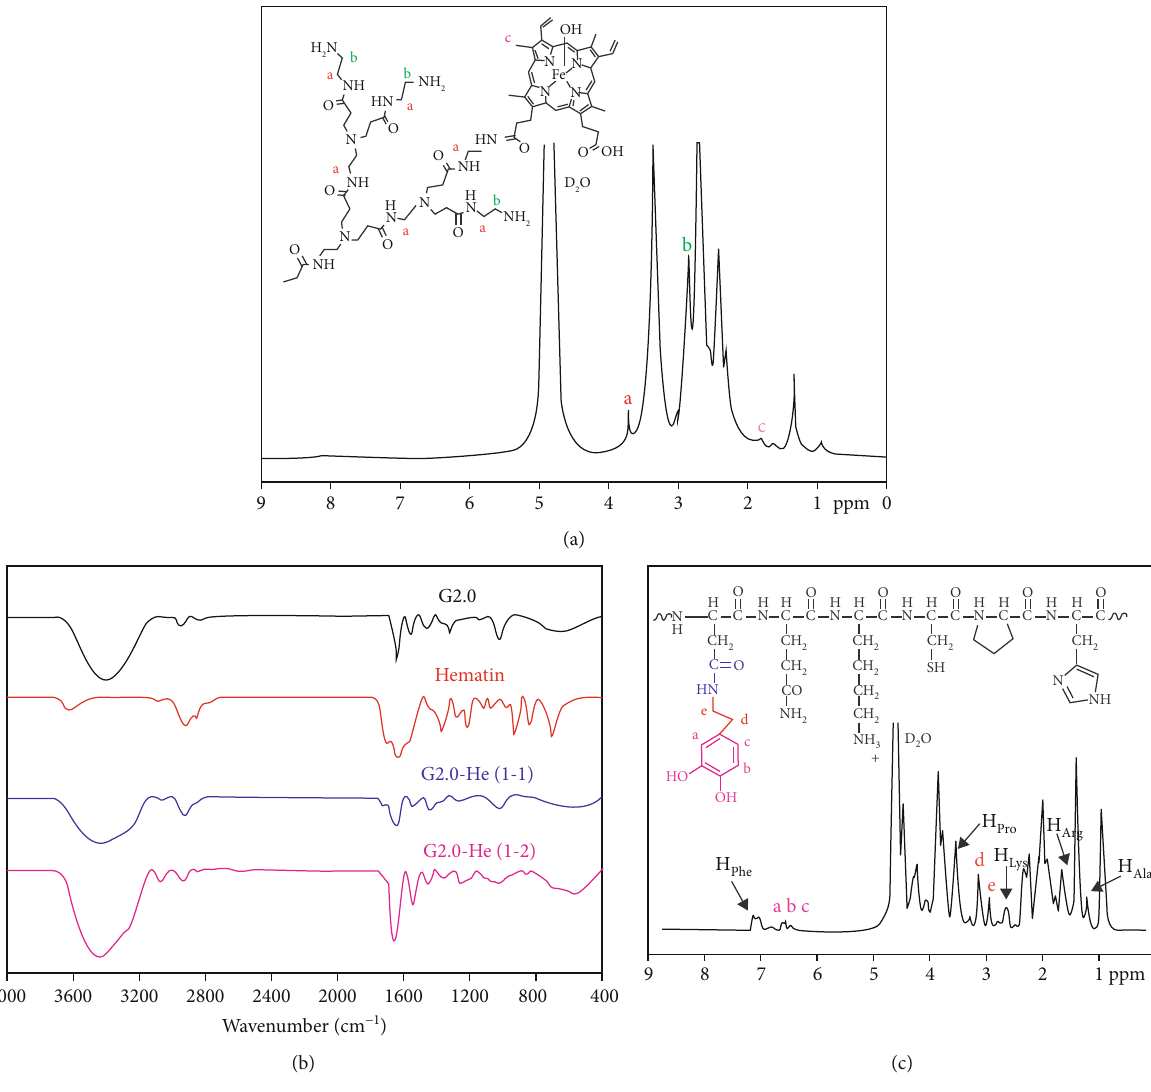
Figure 2: 1 H NMR spectra of G2.0-He (a); FT-IR spectra of PAMAM G2.0, hematin, and G2.0-He (b); 1 H NMR spectra of Gel-Dop